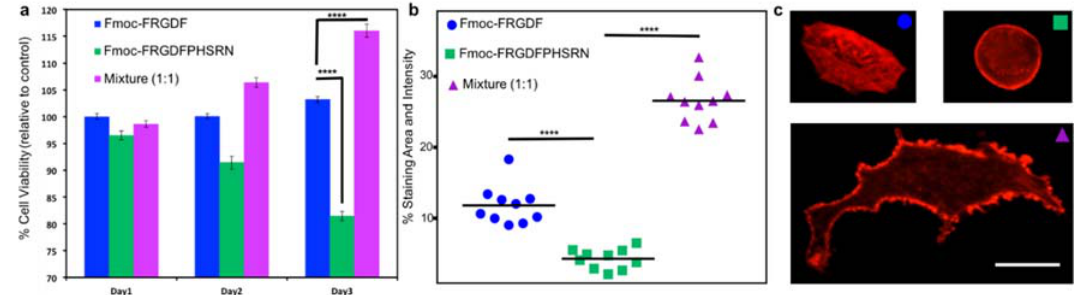
Figure 5. ( a ) Cell viability of HMFCs on peptide hydrogels. HMFCs were cultured on hydrogels containing peptides Fmoc-FRGDF, Fmoc-FRGDFPHSRN and peptide mixture (coassembled Fmoc-FRGDF/Fmoc-PHSRN) for three days. MTS assay was performed and the absorbance values were obtained at a wavelength of 490 nm. Absorbance value of cells grown on Fmoc-FRGDF was considered as control. A p -value of <0.05 was considered significant. ( b ) Analysis of spreading area: HMFCs were cultured on hydrogels containing peptides for 48 h. Cells were stained with actin and the images were obtained using fluorescent microscope (20× magnification). ImageJ analysis was performed and the values were plotted in a graph using GraphPad Prism, the p -value **** <0.05 was considered statistically significant. ( c ) Actin staining of HMFCs growing on hydrogels shows typical morphologies for each condition measured in ( b ) scale bar 10 µm.